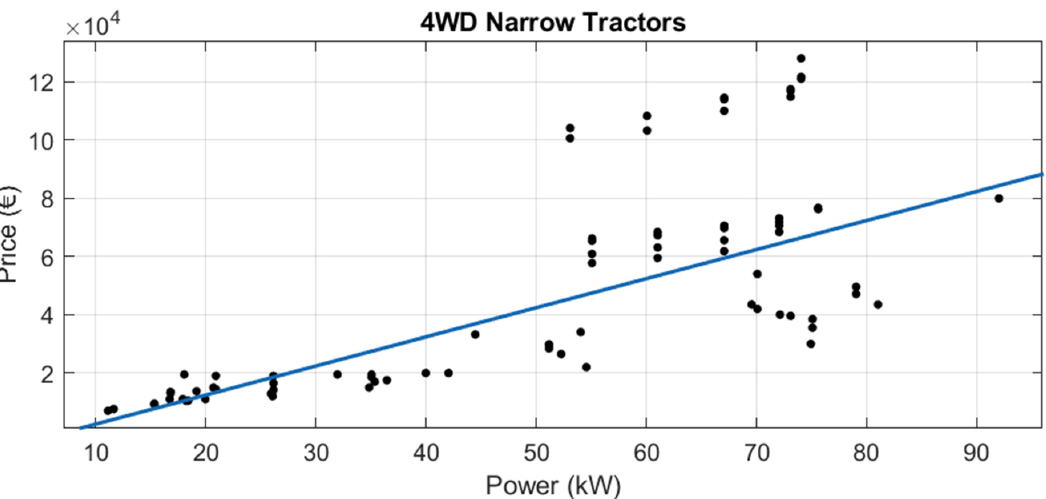
Figure 17. Price vs. power for 4WD narrow new tractors.